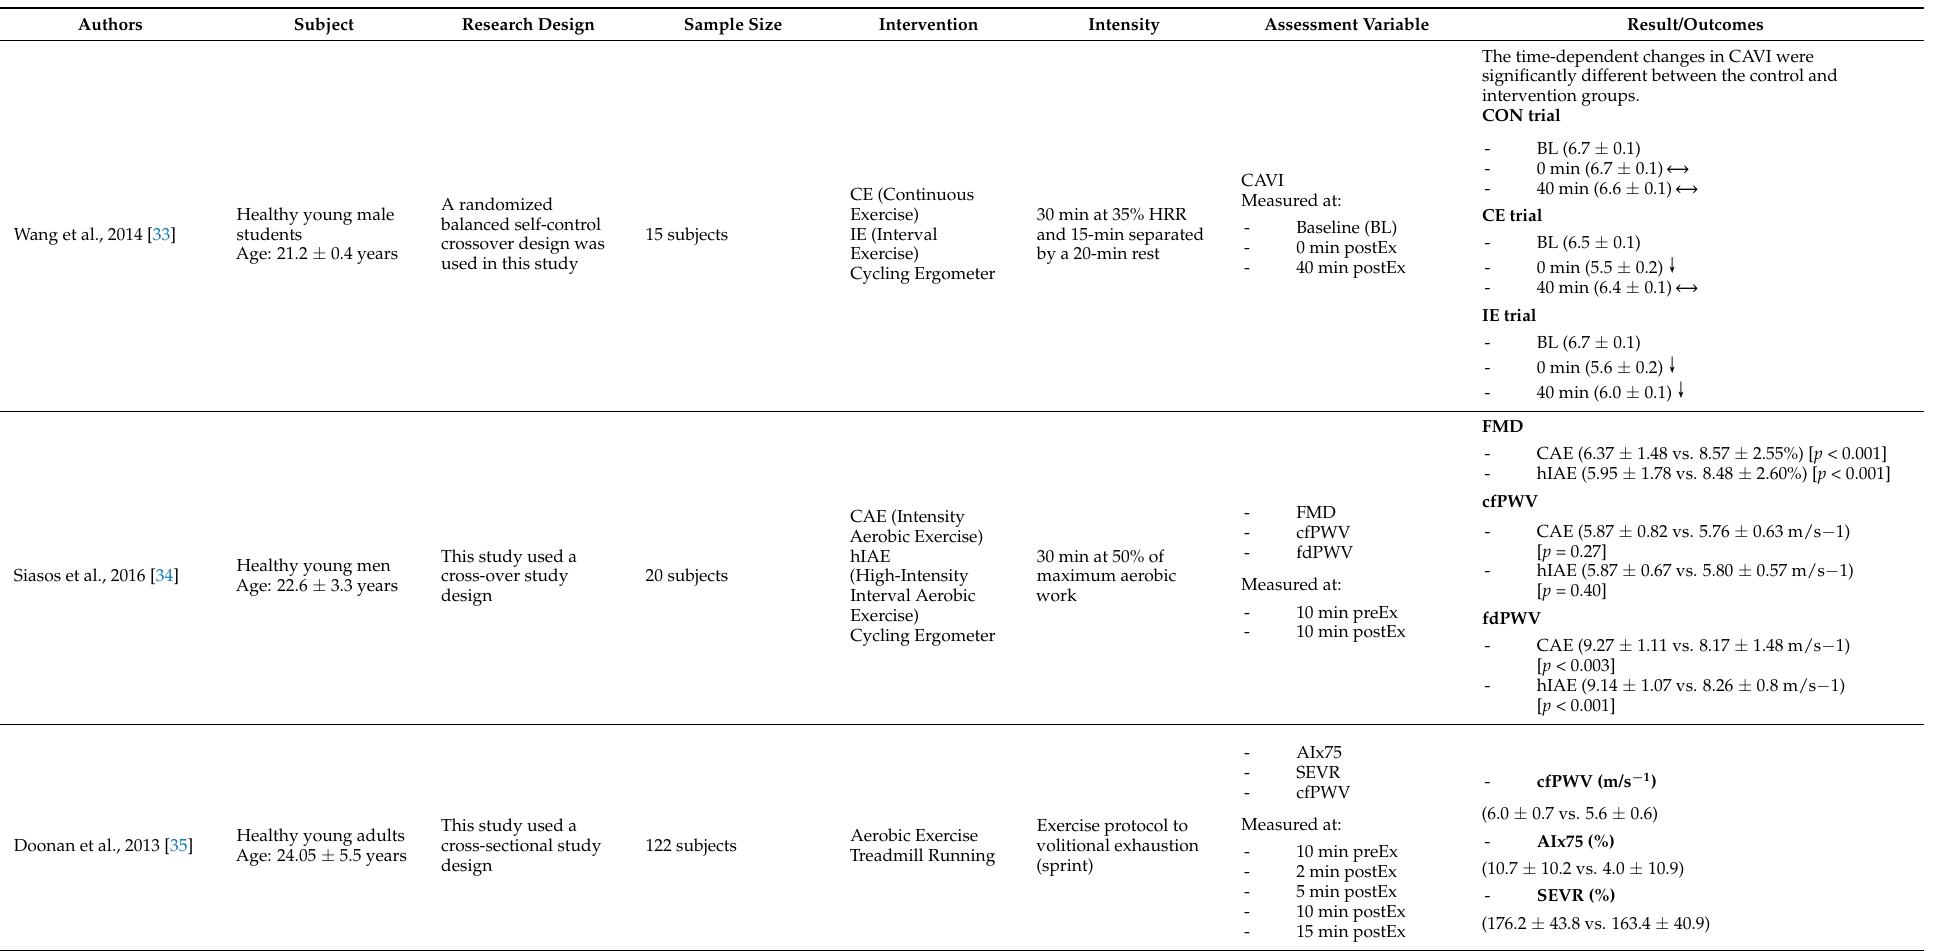
Table 2. Effect of aerobic exercise training on arterial stiffness.